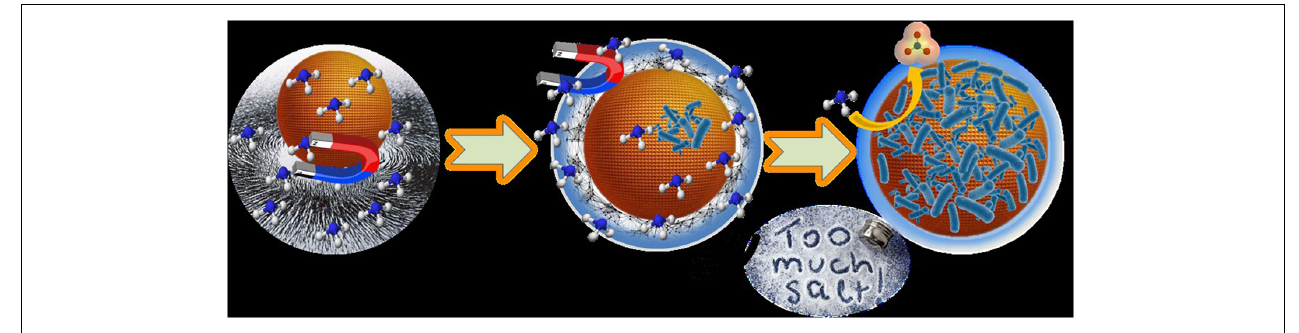
FIGURE 5 | NH 4 + -N removal mechanism by immobilization of Ochrobactrum sp. on BCCP.